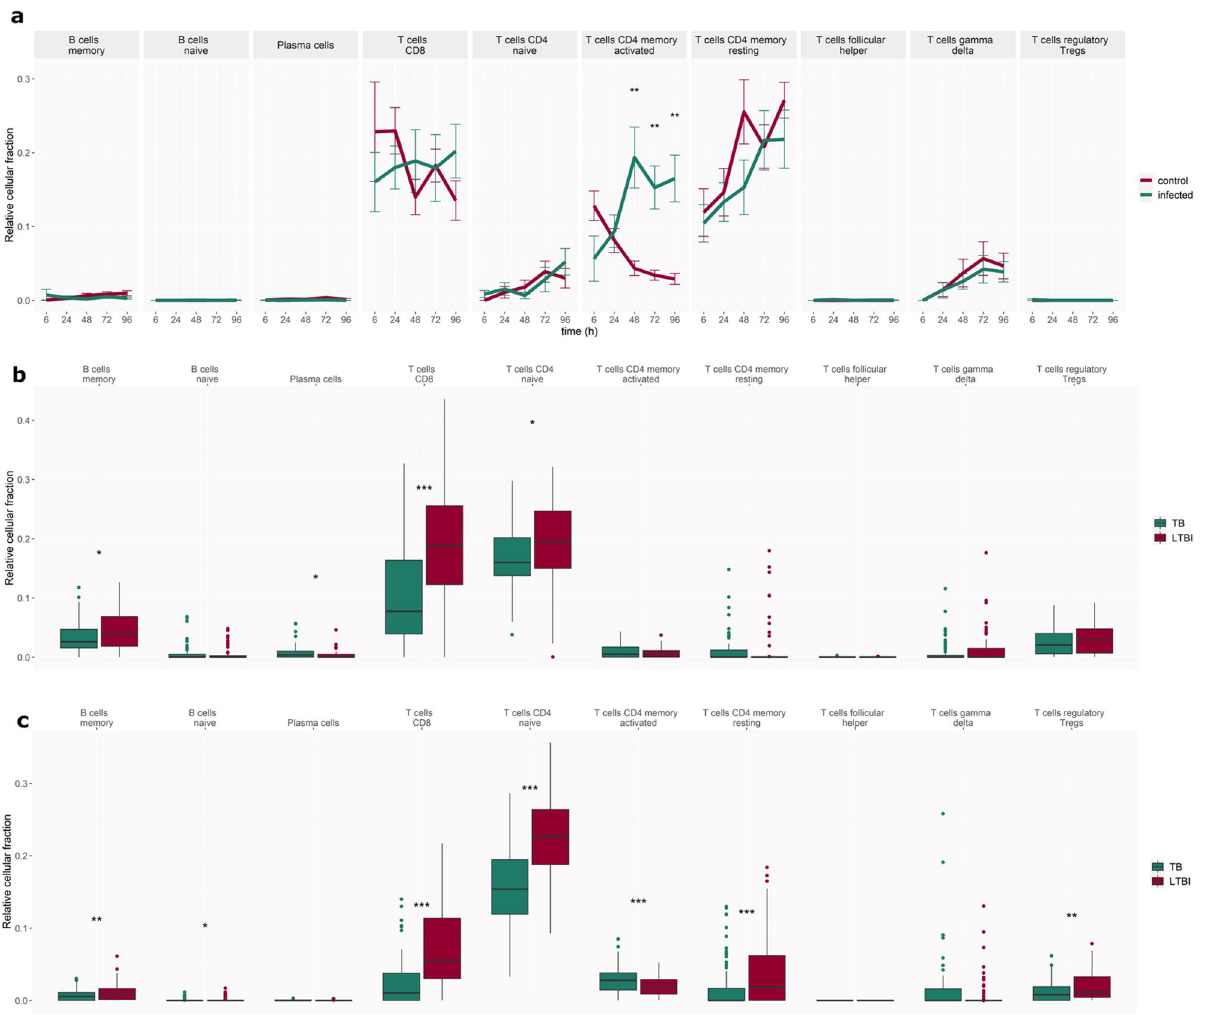
Figure 6. Cell deconvolution using CibersortX—adaptive cells. Changes in adaptive cell fractions ( a ) in vitro over time in the Mtb -infected and control group and in vivo in ( b ) paediatric TB patients and ( c ) adult TB patients and corresponding LTBI control patient groups. Error bars depict standard deviation from the mean, *p < 0.05, **p < 0.005, ***p <